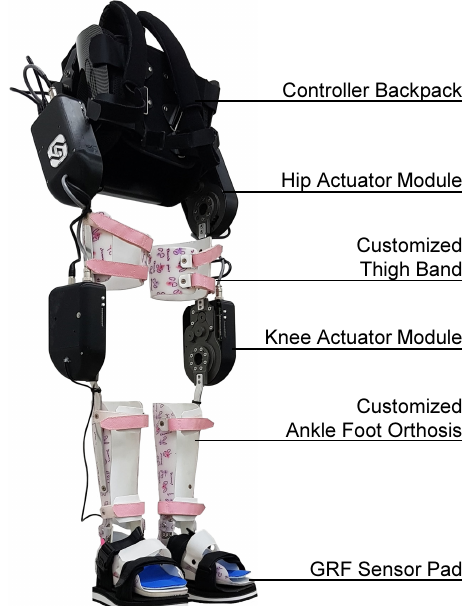
Figure 1. Angel Legs, a lower-extremity powered exoskeleton for assisting joint torques